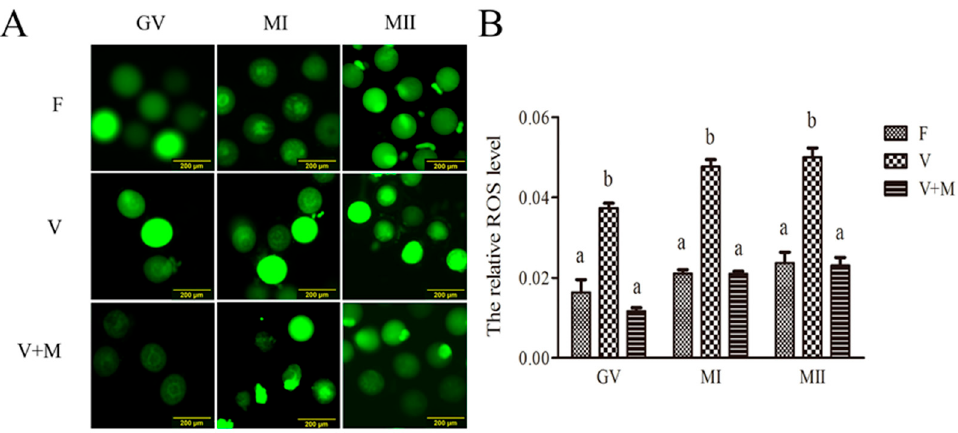
Figure 1. Effects of melatonin (MT) supplementation on reactive oxygen species (ROS) levels in vitrified-warmed mouse GV oocytes during in vitro maturation. ( A ): Representative fluorescence images depicting ROS intensities in vitrified-warmed mouse oocytes at different stages of development (GV, MI, and MII). The oocytes were treated with H 2 DCFDA for detection of ROS levels (green). Fresh control (F), vitrification (V), and vitrification + MT (V + M). Scale bars = 200 µm. ( B ): Quantification of relative levels of ROS in oocytes. Fluorescence intensities of ROS levels were measured using ImageJ software. Data are presented as mean ± SEM of three independent experiments. Total number of GV oocytes used in this assay n = 338 (F: n = 108; V: n = 119; V + M: n = 111). Different superscripts (a, b, and c) indicate significant difference ( P < 0.05) between groups at the same time point (at corresponding developmental stages).